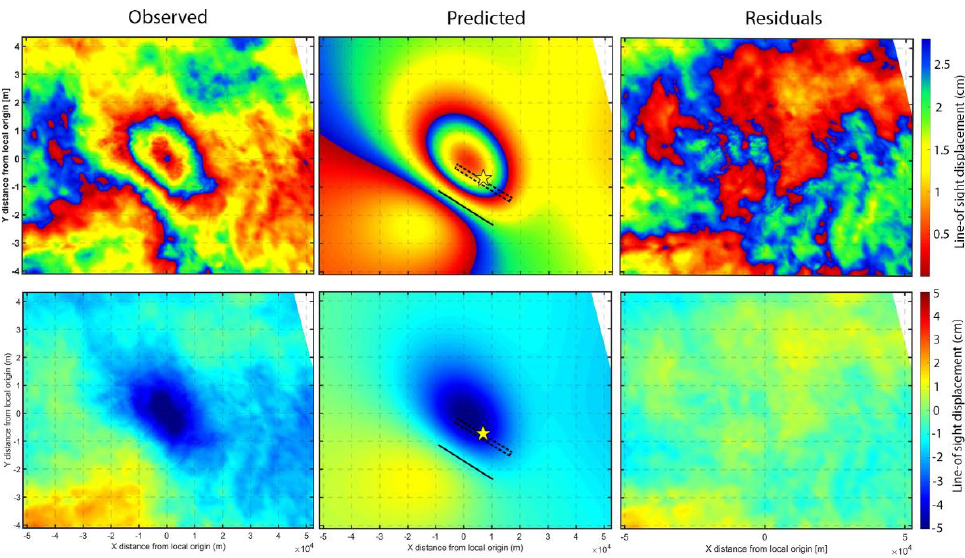
Figure 4. InSAR data and elastic dislocation model for the 3 April 2017 earthquake. Left panels: stack of the wrapped and unwrapped ascending track S1B SAR interferogram spanning the interval 30 March–11 April. Center panels: wrapped and unwrapped best-fitting elastic dislocation model for uniform slip on a rectangular plane obtained from the inversion of InSAR data. The solid black line shows the surface trace of the uniform slip solution, while the dashed black rectangle shows the location of the fault plane at depth. The yellow star locates the epicenter of the mainshock. Right panels: wrapped and unwrapped residuals between the data and the model. Coordinates refer to a local origin (Longitude = 25.12° and Latitude = − 22.63°).